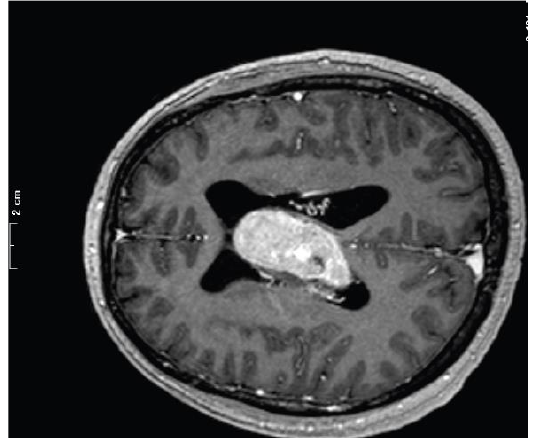
Figure 1. Clinical-pathological features and genomic landscape of six IVMs. The matrix shows seven genes that were altered at sequencing analysis, and the main chromosomal alterations. Table 1. Clinical-pathological features and TMB of six IVMs.